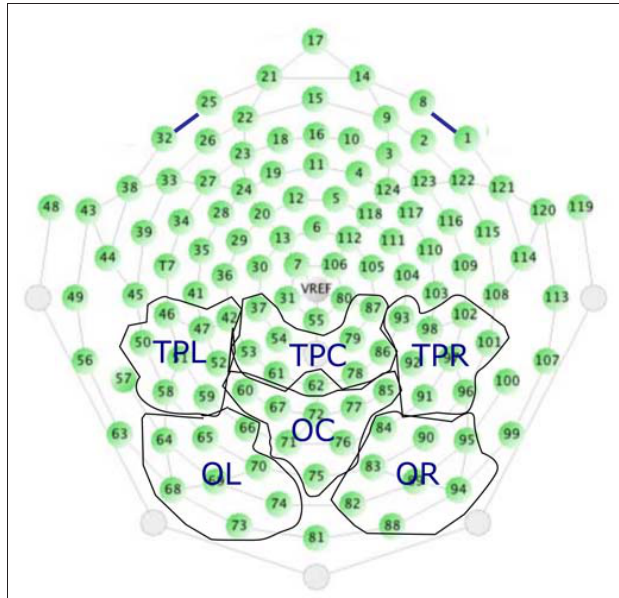
FIGURE 2 | The 48 posterior channels and their pre-defined groupings used for data analysis. The six regions are: Temporal-Parietal-Left (TPL); Temporal-Parietal-Central (TPC); Temporal-Parietal-Right (TPR); Occipital-Left (OL); Occipital-Central (OC); Occipital-Right